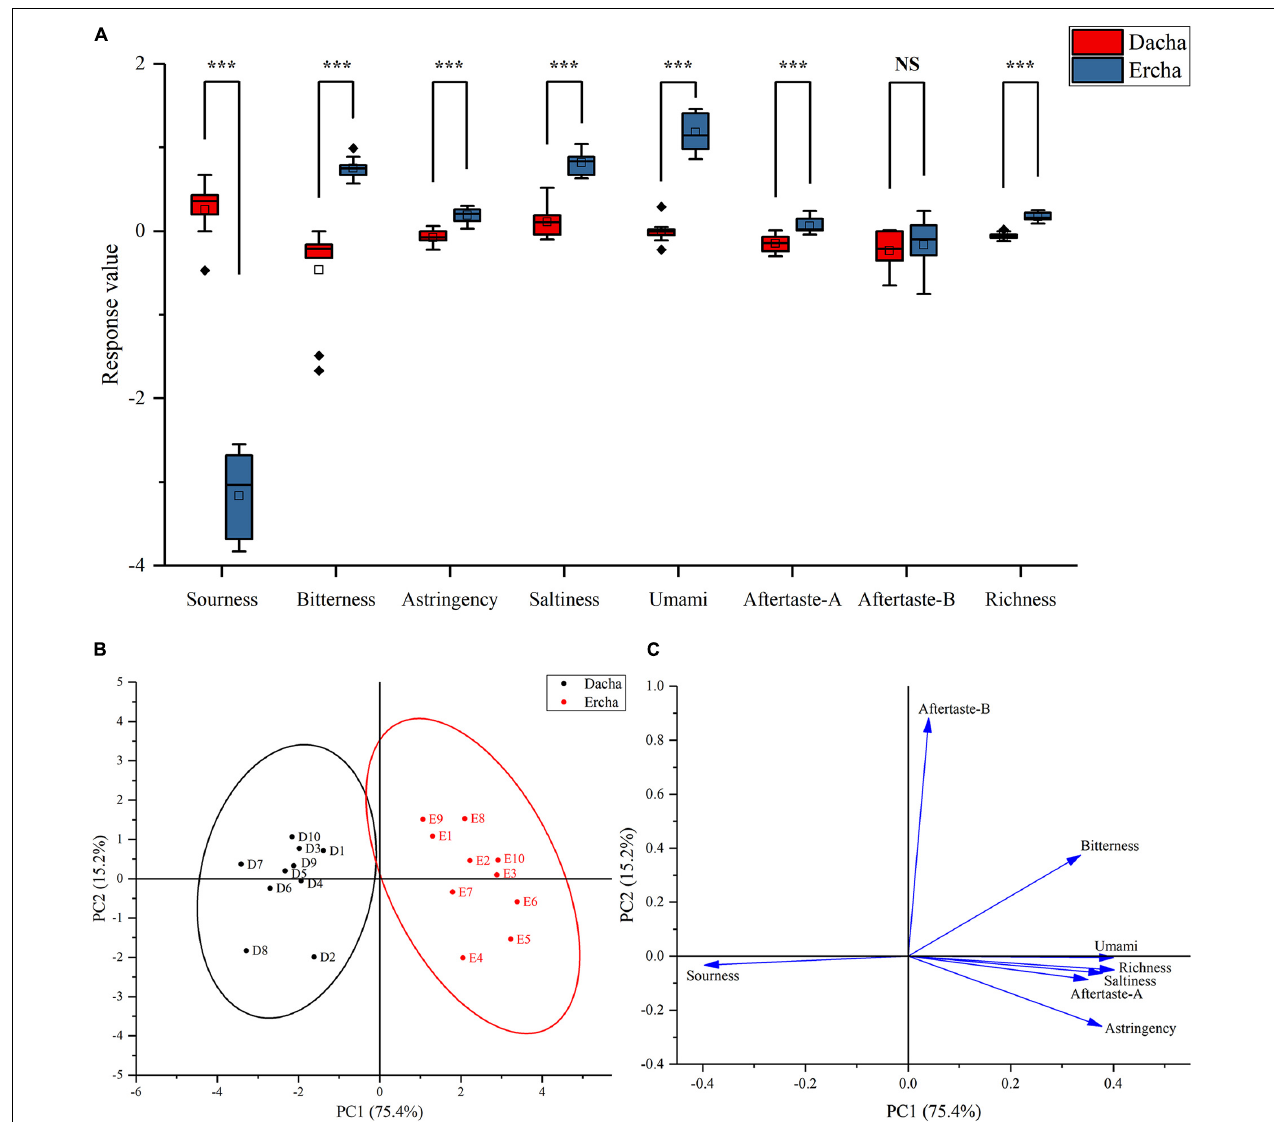
FIGURE 6 | Box plot (A) of response value of electronic tongue, score plot (B) , and loading plot (C) of PCA (NS: P > 0.05, *** P < 0.001).